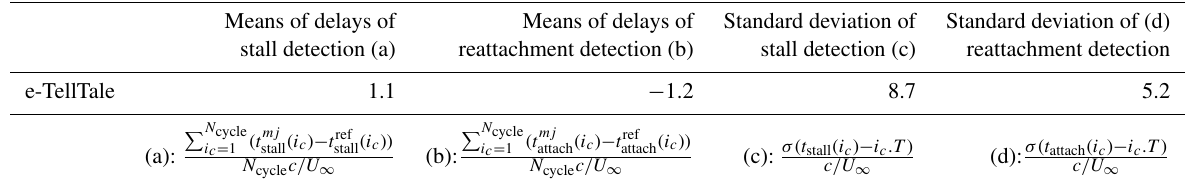
Table 2. Summary of stall–reattachment detected instants, the three methods and the e-TellTale sensors. All times are expressed as chord times ( t c = c/U ∞ ). Means of delays of Means of delays of Standard deviation of Standard deviation of (d) stall detection (a) reattachment detection (b) stall detection (c) reattachment detection